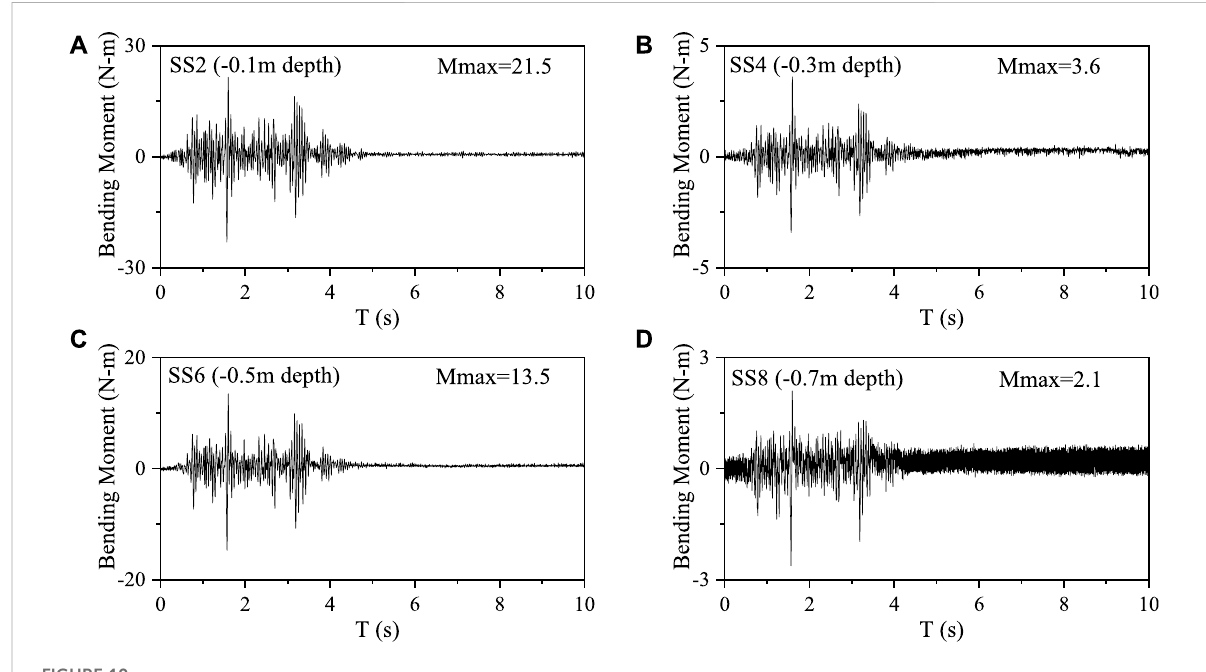
FIGURE 10 Bending moment history of measured points in P2 of container 5# with saturated moisture content under 0.15 g earthquake excitation: (A) SS2 point; (B) SS4 point; (C) SS6 point; (D) SS8